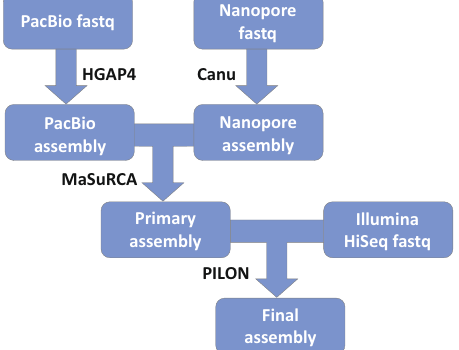
Fig. 1 | Pipeline for assembly of Aspergillus fumigatus CEA10 and A1160 gen- omes. PacBio and Oxford Nanopore reads were assembled using PacBio HGAP4 and Canu 19,20 , respectively. The assemblies were not full length at this point. The 5 ’ end of chromosome 6 and the rRNA repeat region caused breaks in the sequence for PacBio assemblies of both A1160 and CEA10. Oxford Nanopore assemblies included these regions but did not cross the centromere for chromosome 4 for both strains. PacBio and Oxford Nanopore assemblies were then combined using CEA10 assembly consisted of 8 chromosomes with telomere sequence for both chromosome ends and no gaps. The primary A1160 sequence consisted of 6 complete chromosome regions using the CEA10 sequence as comparator lacked Oxford Nanopore coverage of the 5 ’ end of chromosome 6 or centromeres of chromosomes 1, 2, and 5. Finally, the CEA10 assembly was polished using Illumina HiSeq 2500 paired end 2×150 reads from two CEA10 libraries with predicted 73 and 81 fold coverage of the genome. PILON was used for rounds of assembly until no further improvements in the sequence were observed (4 rounds in